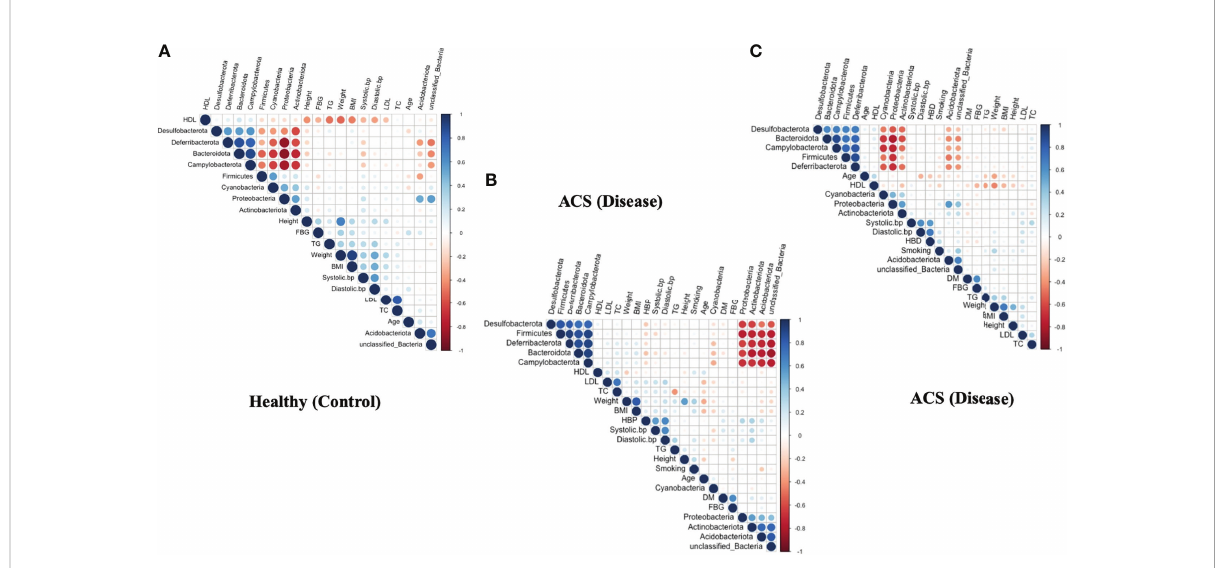
FIGURE 5 Correlation between clinical parameters and microbial taxa at the phylum level. (A) shows a correlation between clinical parameters and microbial taxa in the ACS group. (B) indicates a correlation between clinical parameters and microbial taxa in the CCS group. (C) indicates a correlation between clinical parameters and microbial taxa in the Healthy